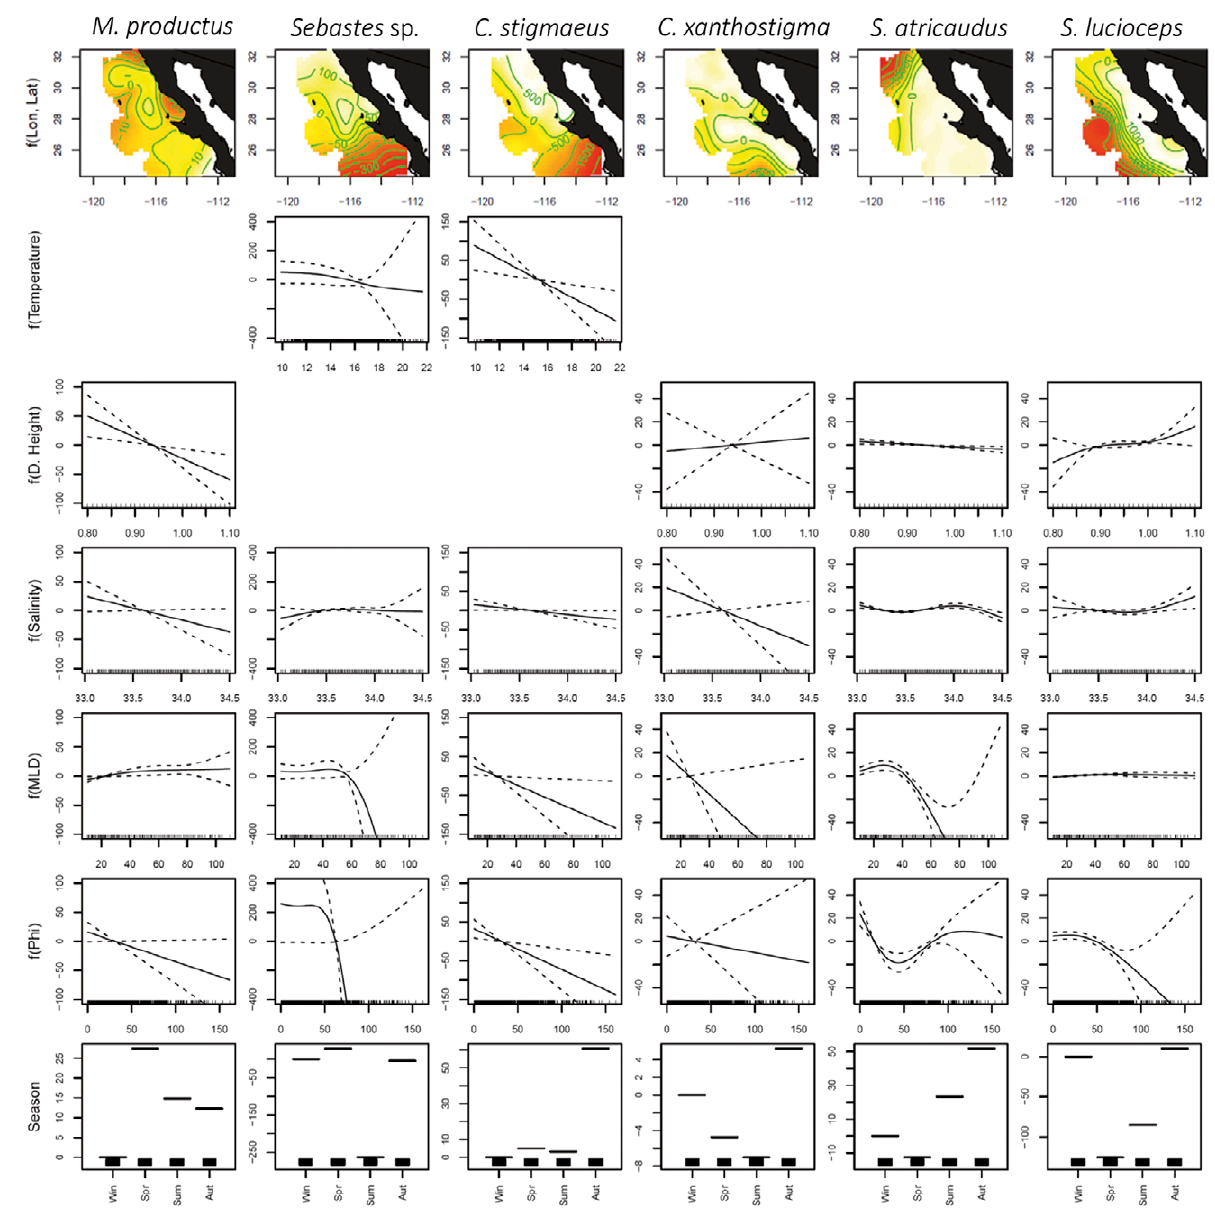
Fig. 3. – Response plots for predictor variables of larvae of six demersal species off the western coast of the Baja California Peninsula during the study period (1997-2000 and 2006-2010) from the best-fitted GAMs. Contour plots indicate species preferred distributions with values on the response scale given by the contours, with lighter colour indicating higher values. The solid line indicates the smooth function or the parametric coefficients; the dashed lines are the standard error and tick marks at the foot of each plot are observations of the